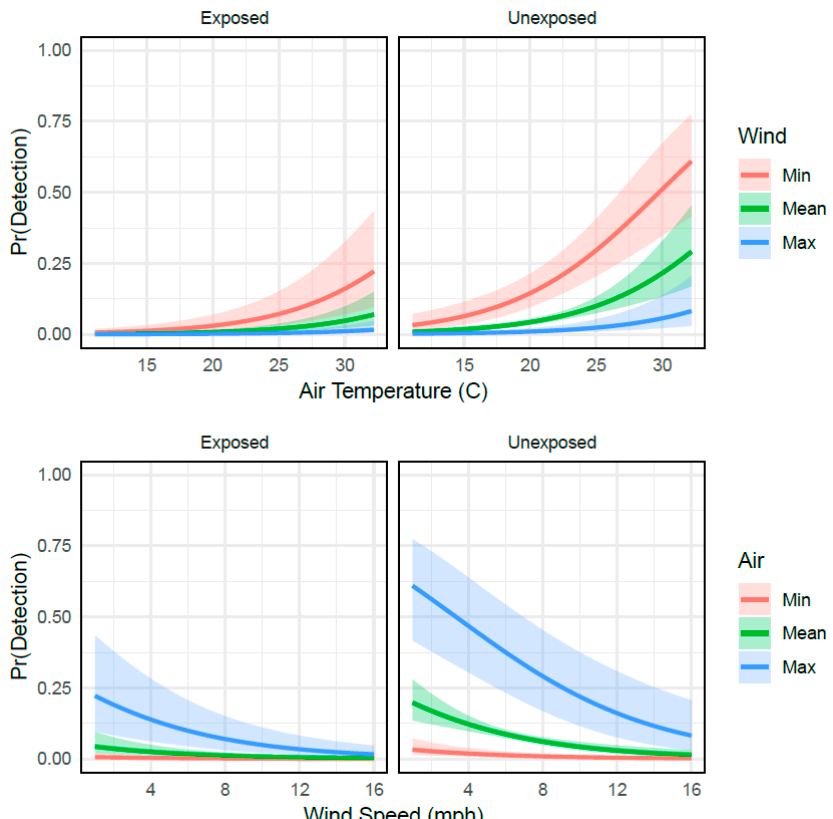
Figure 2. Per individual detection probability of diamondback terrapin heads by exposure category (Exposed, left ; Unexposed, right ) and as a function of air temperature (Celsius, top ) and wind speed (miles per hour, bottom ). The influence of air temperature on detectability is shown at the minimum, mean, and maximum wind speed observed during surveys ( top ). The influence of wind speed on detectability is shown at the minimum, mean, and maximum air temperature observed during surveys ( bottom ). Solid lines are maximum likelihood estimates, and polygons are the 95% confidence intervals.